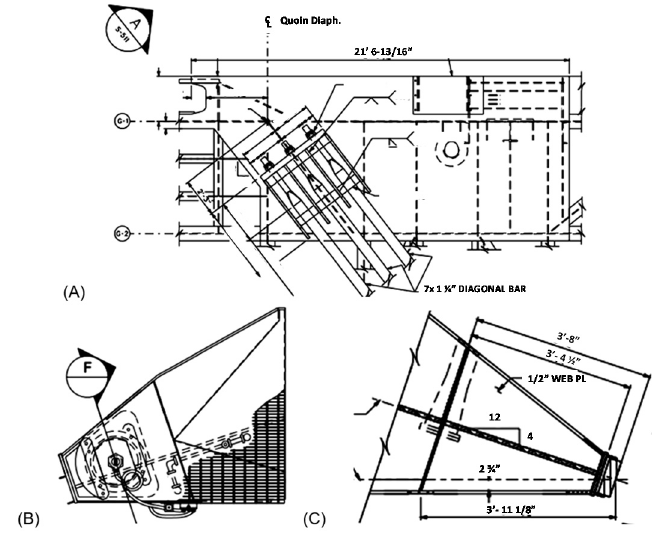
Figure 3. Greenup lock gate details: ( A ) diagonal tension element connection, ( B ) quoin end detail, and ( C ) miter end detail.